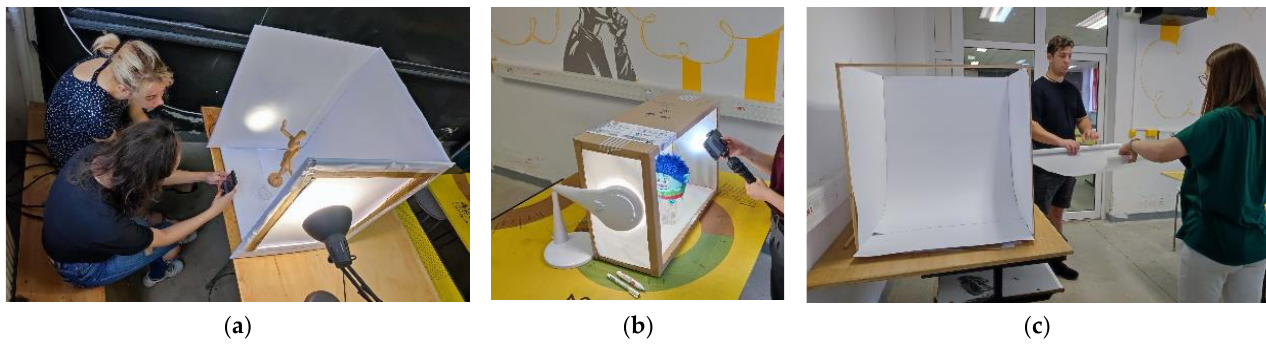
Figure 1. Students testing various Light Box photography techniques ( a ) Light box 1; ( b ) Light box 2, ( c ) Light box 3.